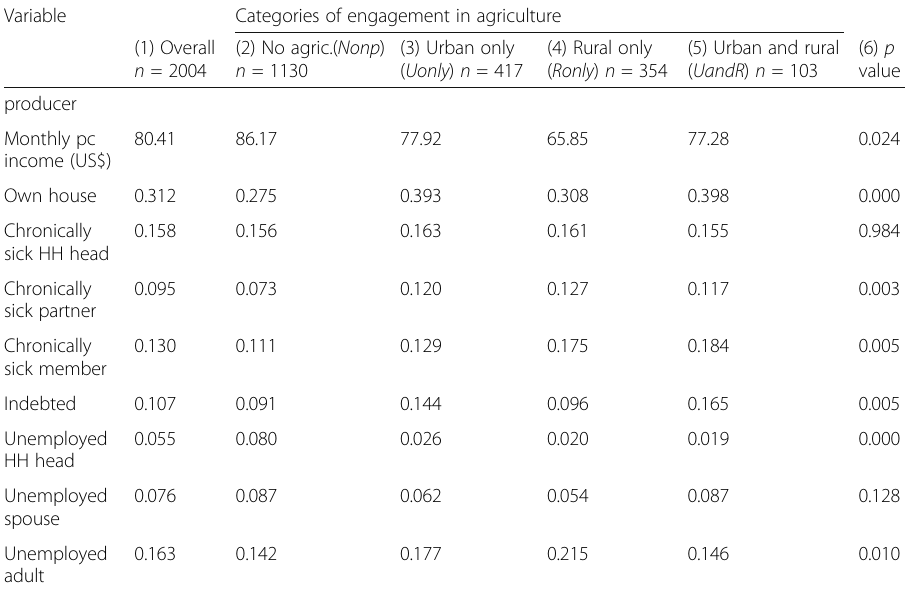
Table 2 Sample mean statistics by agricultural participation categories (Continued) Variable Categories of engagement in